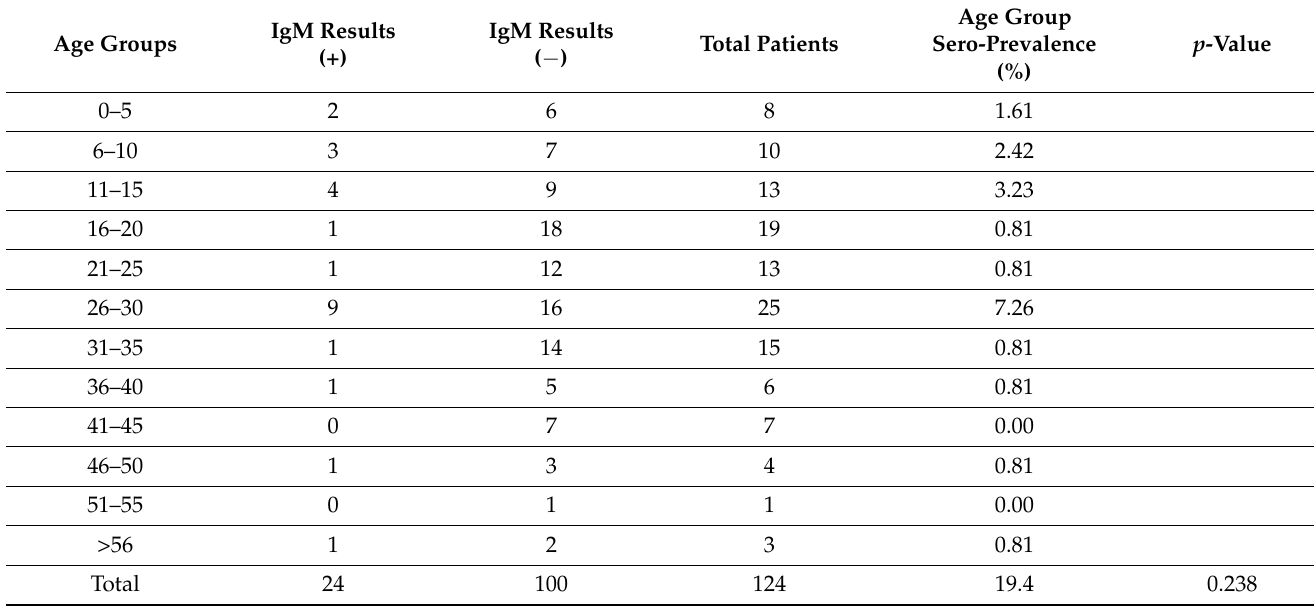
Table 4. Dengue virus infection detection among patients in Jimeta, Yola, by age group.